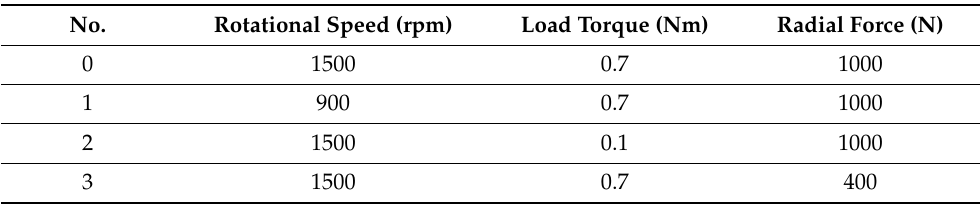
Table 1. Test rig operating conditions.